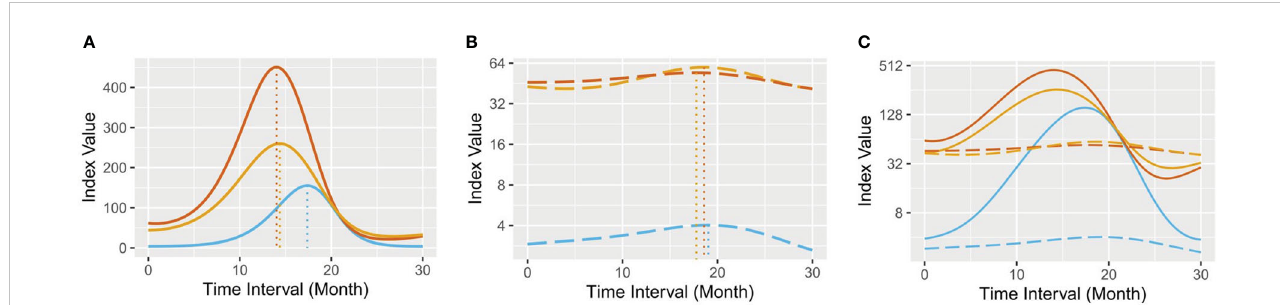
FIGURE 3 Predicted GAM plots for serum AFP, ALT and AST. (A) the remission group; (B) the progression group; and (C) all samples. In each plot, the blue line represents the GAM of serum AFP, the red line represents the GAM of serum ALT, and the orange line represents the GAM of serum AST. The full lines represent the remission group, and the long-dashed lines represent the progression